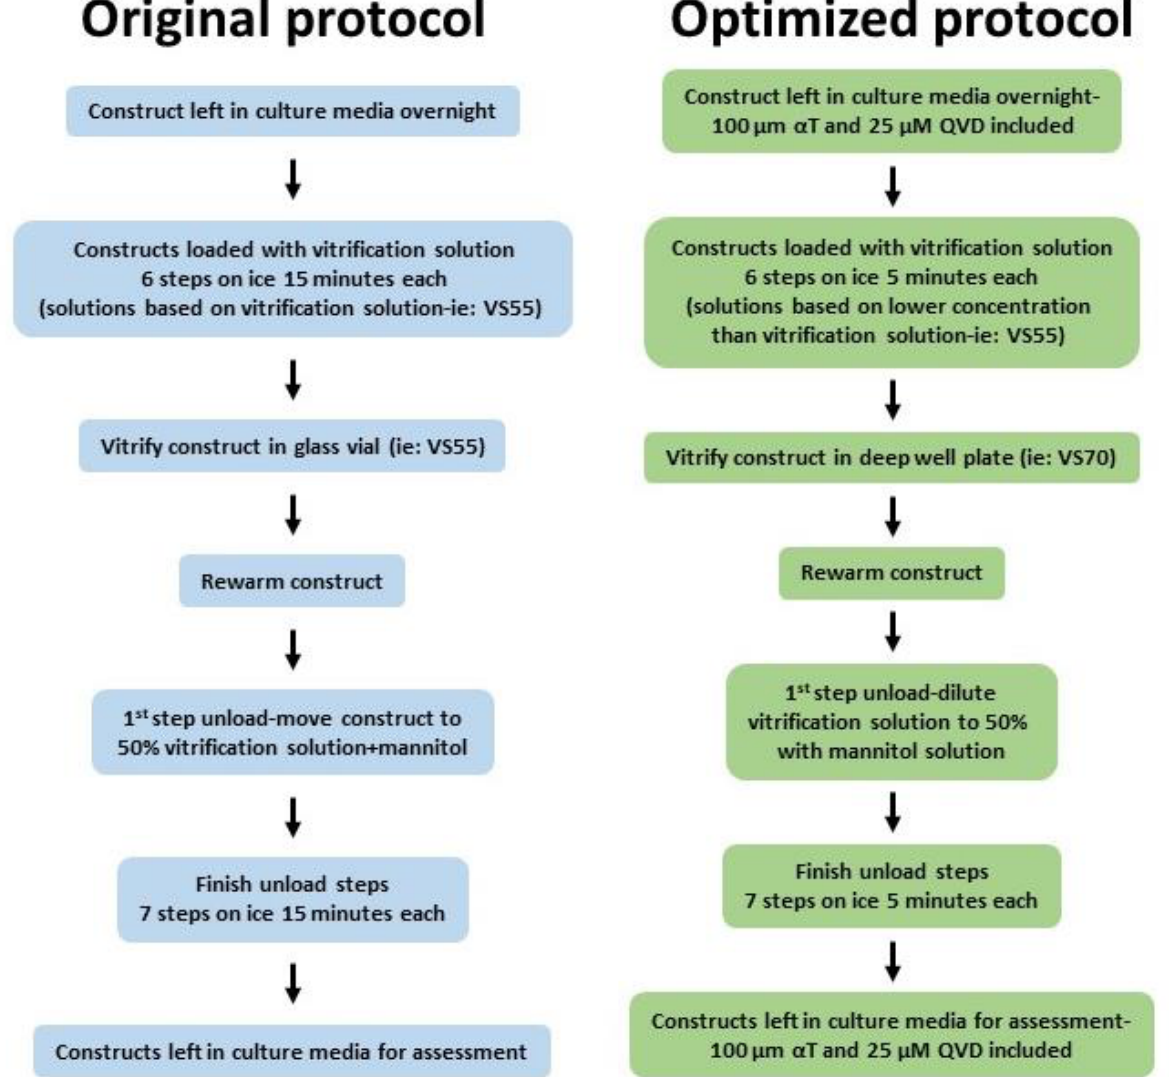
Figure 11. Vitrification protocols. Flow charts showing the steps for our optimized vitrification protocol for bioengineered constructs and the original vitrification protocol used with blood vessels.